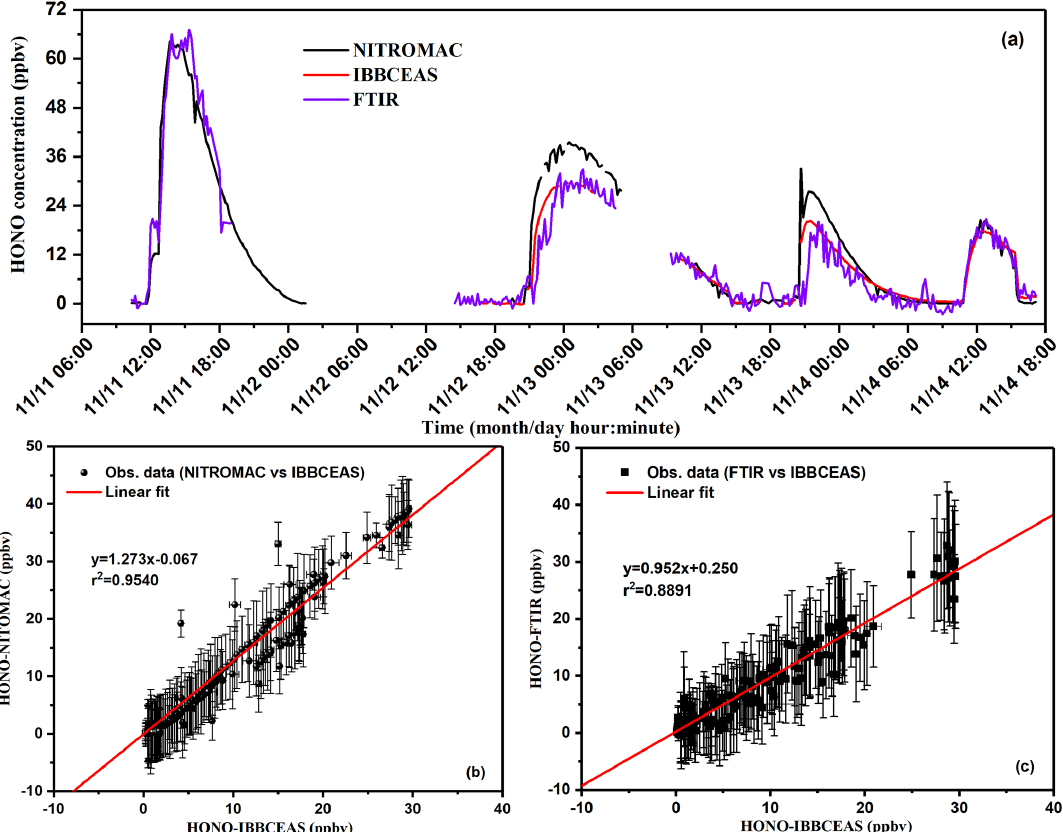
Figure 8. (a) HONO intercomparison measurements between IBBCEAS, NitroMAC and FTIR; (b) regressions analysis for the correlation of the measured HONO concentrations using UV-LED-IBBCEAS and NitroMAC; (c) correlation of the measured HONO concentrations between UV-LED-IBBCEAS and